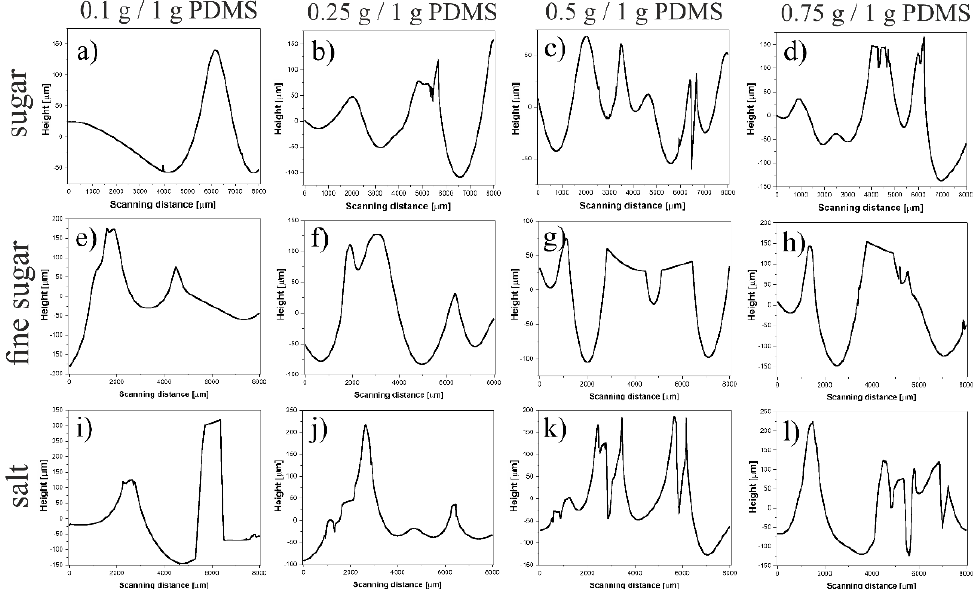
Figure 5. Cross-sectional profiles of 3D PDMS structures prepared by adding ( a – d ) sugar, ( e – h ) fine sugar, and ( i – l ) salt to the PDMS mixture.